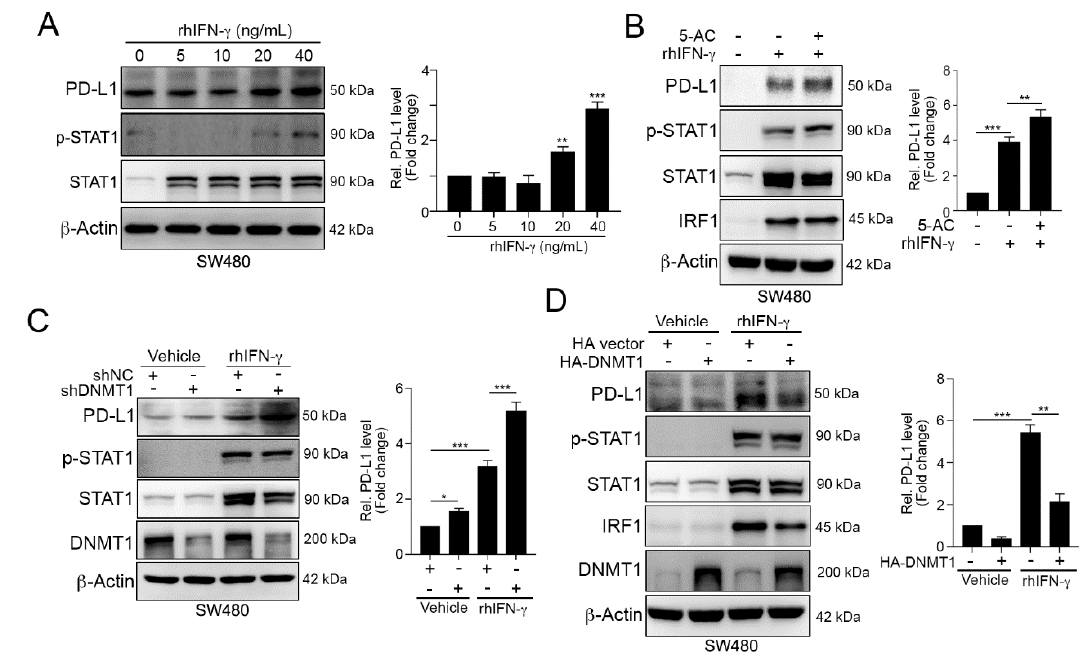
Figure 3. DNMT1 influenced the IFN γ -mediated upregulation of PD-L1 expression. ( A ) SW480 cells were treated with different concentrations of recombinant human IFN- γ (rhIFN- γ ) for 24 h and then analyzed by immunoblotting. The quantification of these results is shown on the right ( n = 3); ** p < 0.01 and *** p < 0.001. ( B ) SW480 cells were cotreated with rhIFN- γ (10 ng / mL) and 5-AC (2.5 µ M) for 24 h and then examined by immunoblotting. The quantification of these results is shown on the right ( n = 3); ** p < 0.01 and *** p < 0.001. ( C ) SW480-shNC and SW480-shDNMT1 cells were directly treated with IFN- γ (10 ng / mL) for 24 h and then analyzed by immunoblotting. The quantification of these results is shown on the right ( n = 3); * p < 0.05 and *** p < 0.001. ( D ) SW480 cells were transfected with HA-vector or HA-DNMT1 for 24 h and then treated with a high-dose of IFN- γ (40 ng / mL) for 24 h. Cell lysates were harvested and then analyzed by immunoblotting. The quantification of these results is shown on the right ( n = 3); ** p < 0.01 and *** p < 0.001. These data were obtained from three independent experiments, and the values represent the mean ± S.D.